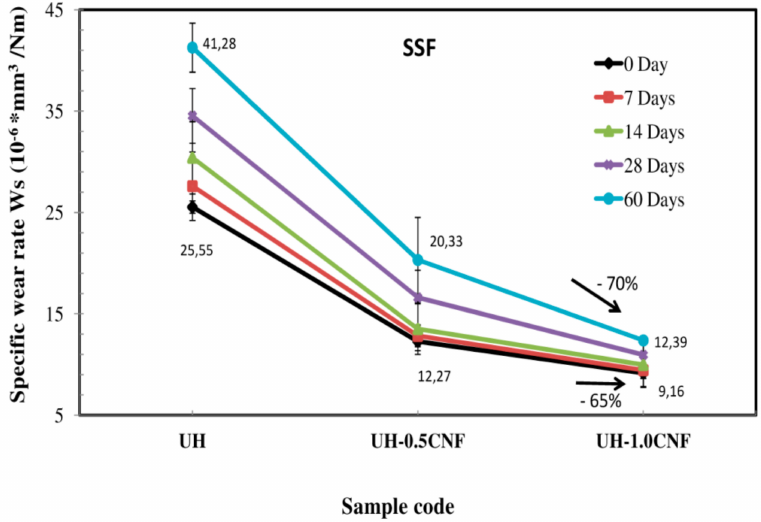
Figure 1. Specific wear rate of UH, UH-0.5CNF, UH-1.0CNF samples for 60 days of ageing in